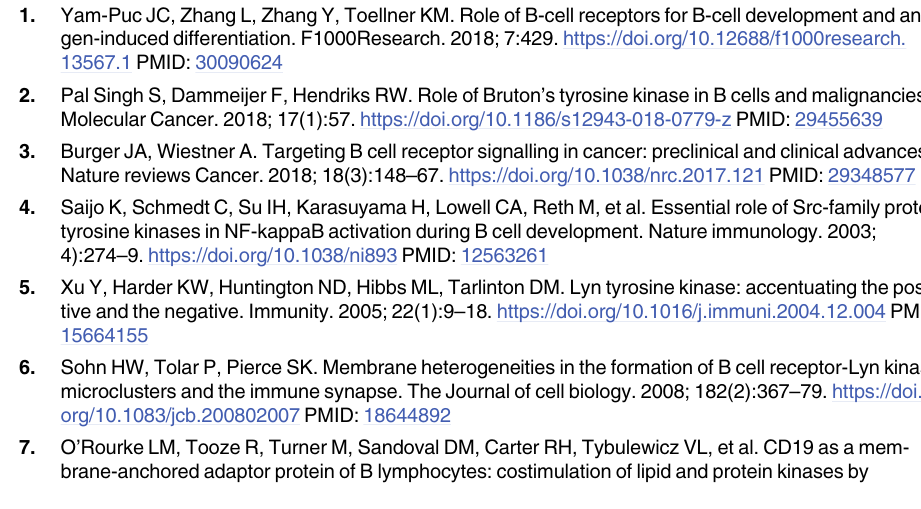
S3 Fig. Effect of LUX and IB on anti-IgM-induced phosphorylation of LYN in JeKo-1 and RL cells. Cells were pre-treated with vehicle or 1 μ M LUX or IB for 2 h followed by stimulation with anti-human IgM for 5 min. Western blot analysis of LYN immunoprecipitates using anti- bodies for phospho-Src (Y416) and LYN in (A) JeKo-1 and (B) RL cells. Histograms show quantification of phospho-Src (Y416) band intensity relative to that LYN. Data is mean ± SEM of data from 2 independent experiments. Representative blots are shown. �� p < 0.001. (TIF) S1 Table. Relative sensitivity of lymphoma cell lines to LUX and IB. Table showing IC ues for LUX and IB in SU-DHL-6, JeKo-1 and RL cells. Data is mean ± SEM of 3-independent